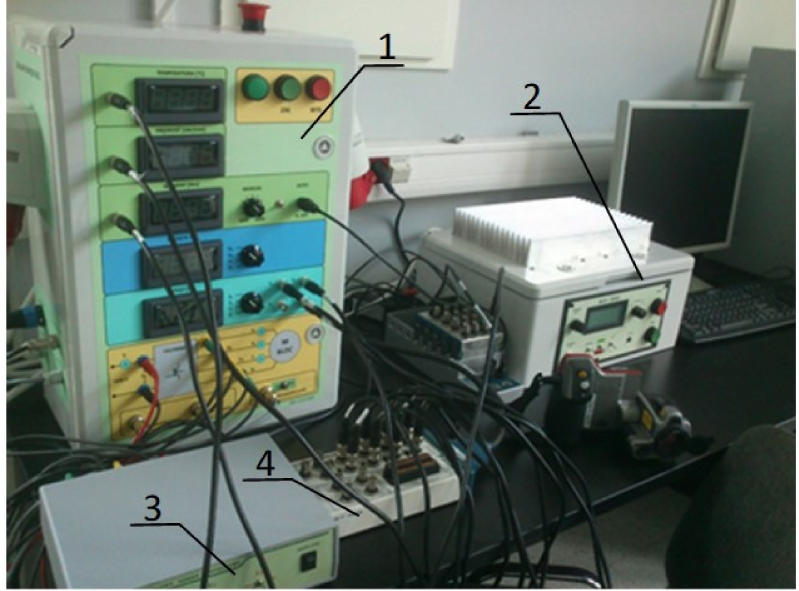
Figure 9. View of the system elements for measuring electrical quantities of the motor-pump unit. 1—measurement-control panel, 2—converter, 3—differential probe, 4—BNC-2110 connector